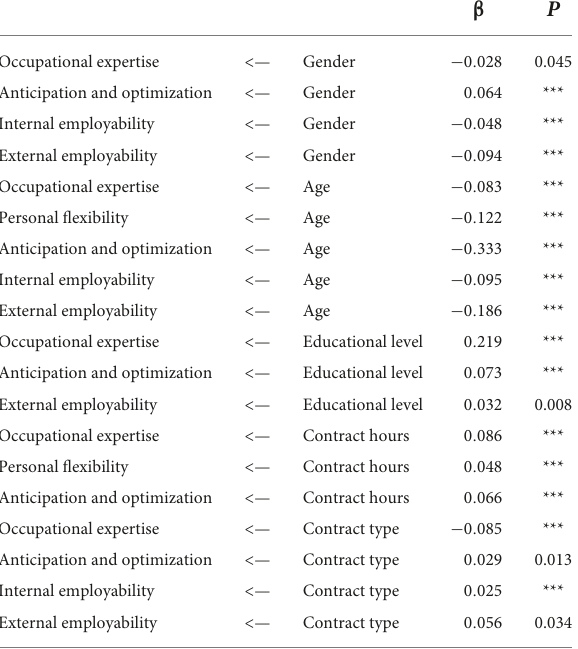
TABLE 2 Standardized regression